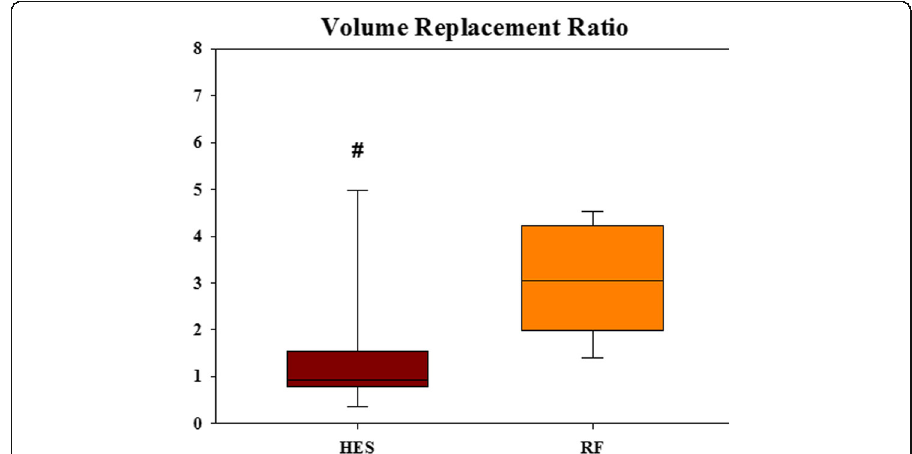
Fig. 3 Volume-replacement ratio: resuscitation fluid/total blood loss. Data are presented as median [IQR]. p =0.002